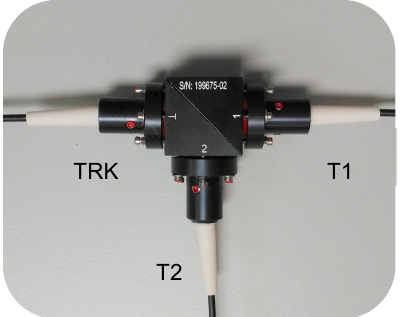
Figure 1. Custom-made pigtail-style Y-coupler designed for plastic optical fibers. The three ports are labeled as TRK (common port), T1 (95% of output power) and T2 (5% of output power), respectively.